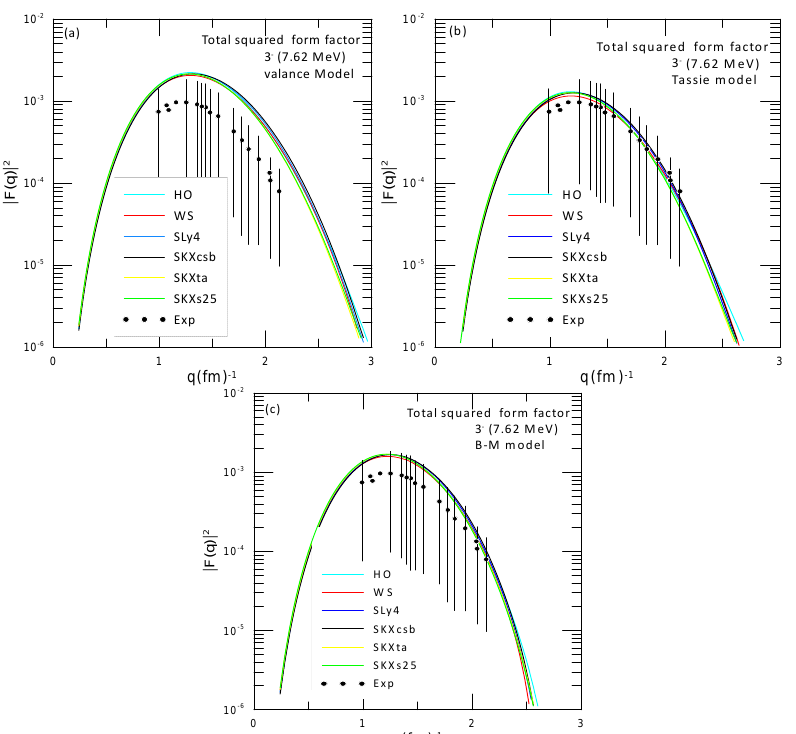
Fig. 9: Total squared form factors for the second 3 1- , 7.62 MeV state using different single particle potential compared with the experimental data taken from Ref.